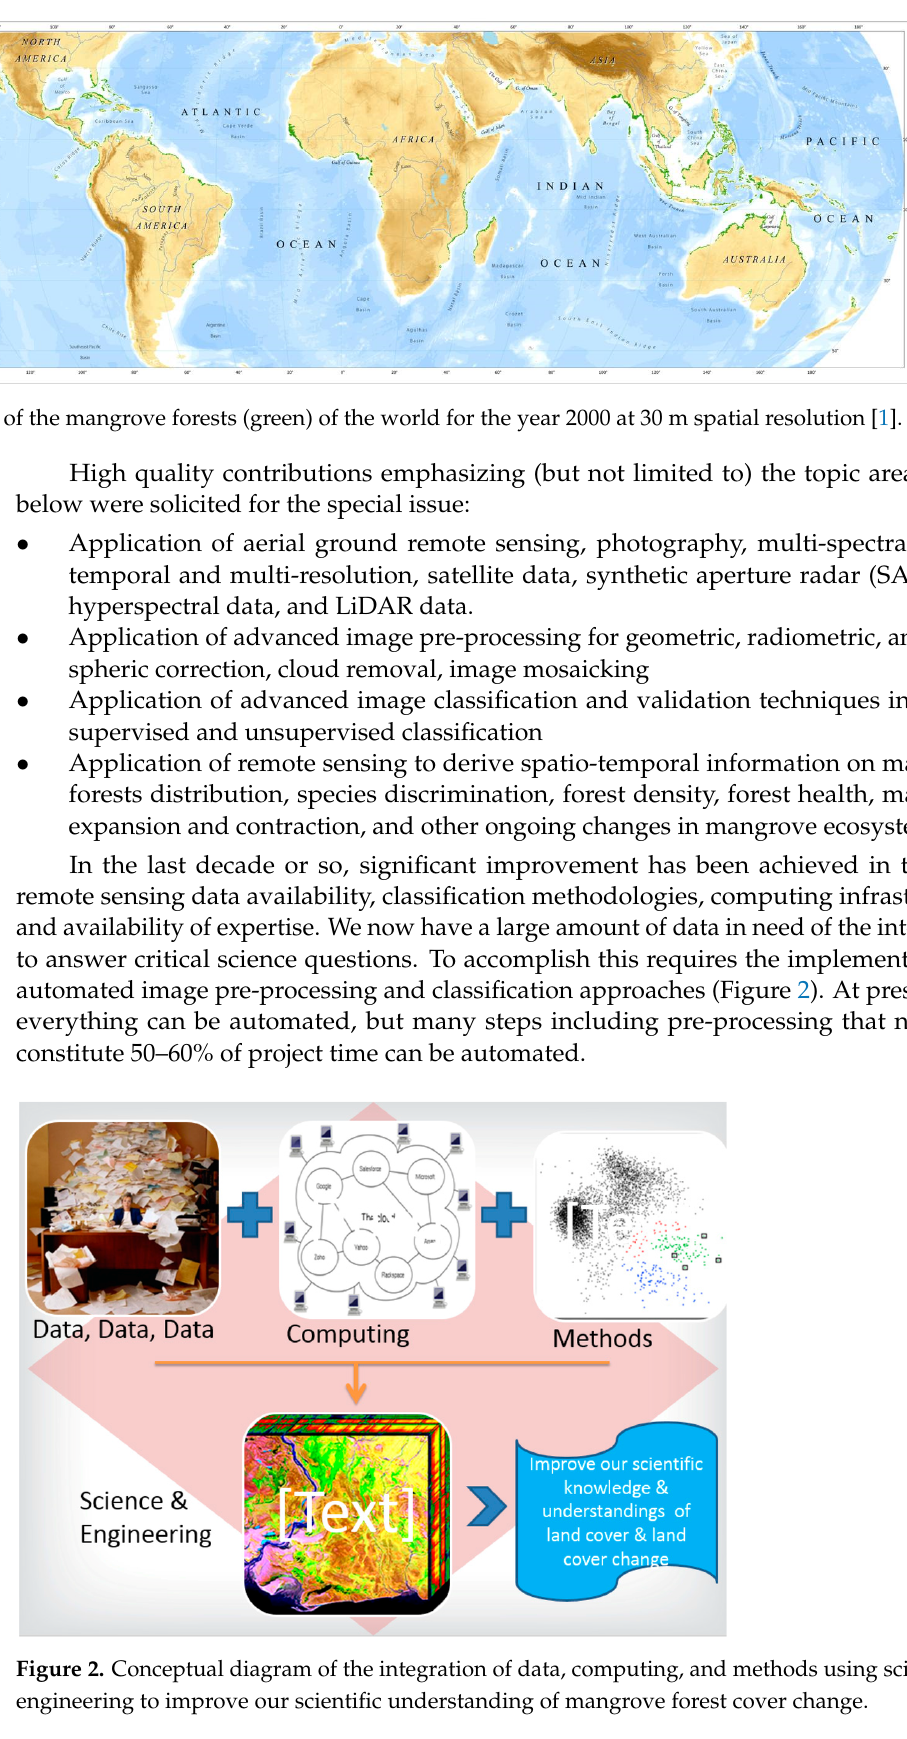
Figure 3. Conceptual framework of pre-processing and image classification showing centralized versus field/ground/local level processing. The recent trend has been to perform image processing using cloud computing such as Google Earth Engine (GEE) and Amazon Web Services (AWS). Using parallel compu- ting, users will have unlimited computer processing capabilities. Moreover, code and clas- sification algorithms can be shared and discussed in the shared platform. The few disad- vantages include a lack of full control of the cloud-computing platform, cost, and the fact that documents are not available or fully explained in some cases.